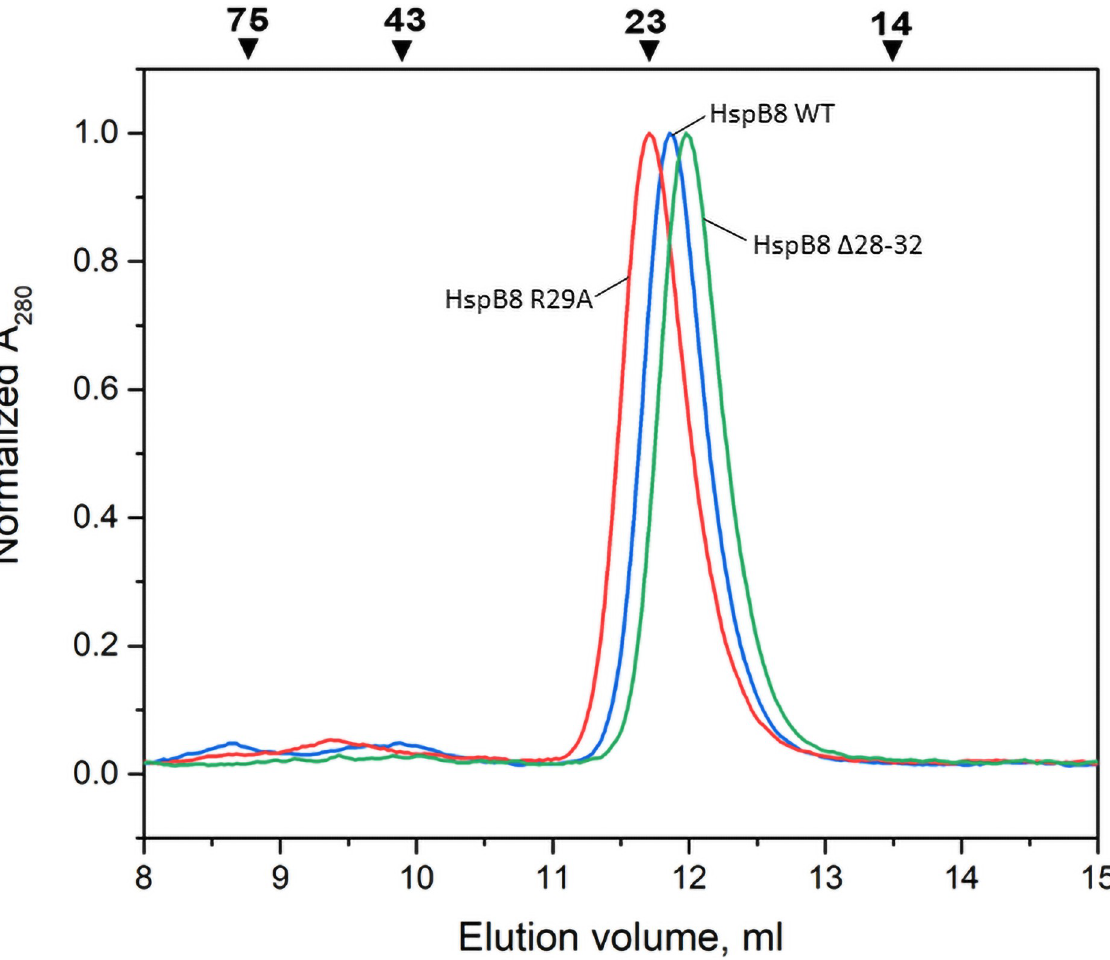
Fig 2. Size-exclusion chromatography of HspB8 WT (blue), R29A (red) and Δ 28–32 mutant (green) in the presence of 6 M guanidinium chloride. Apparent Mw values (kDa) are indicated by arrows. https://doi.org/10.1371/journal.pone.0253432.g002 PLOS ONE | https://doi.org/10.1371/journal.pone.0253432 June 18,